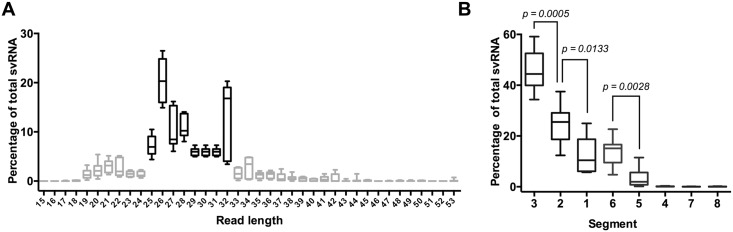
Size and segment distributions of svRNA reads.(A) Percent of total svRNA attributed to each read length. (B) Percent of total svRNA attributed to each segment. Segments were sorted from most represented to least represented in the svRNA and segment percentages were compared with unpaired t-tests.